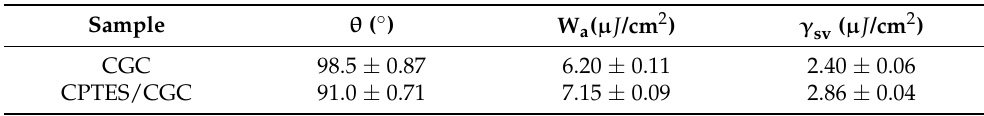
Table 2. Water contact angle, work of adhesion, and surface free energy values measured on the surface of